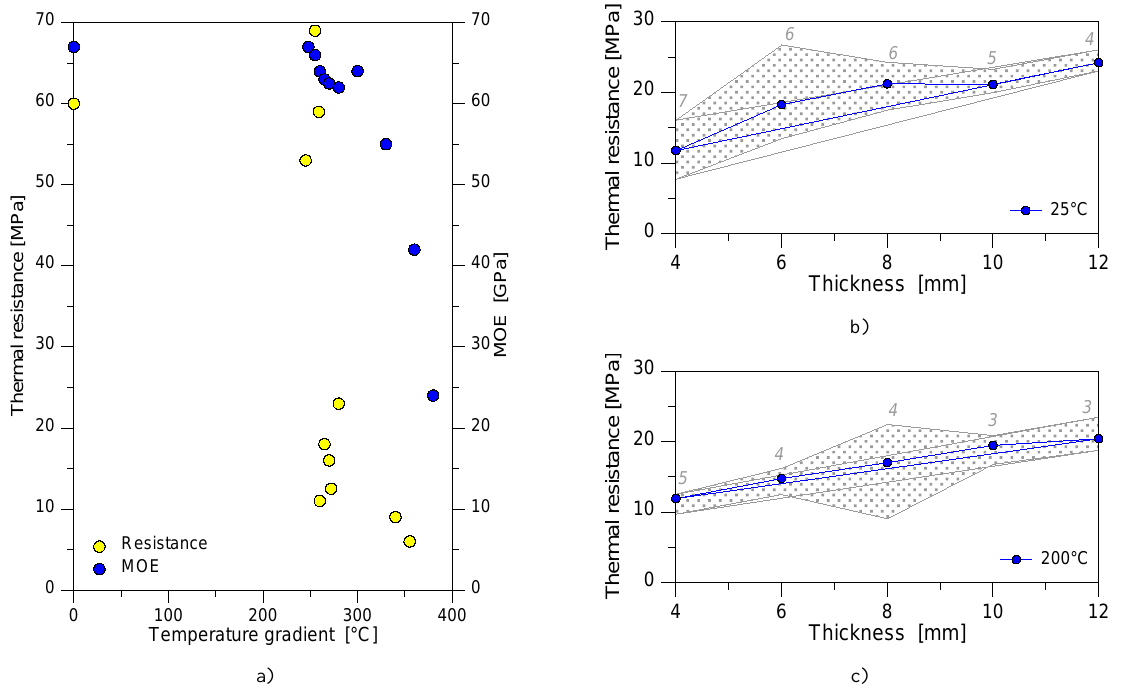
Fig. 2 Thermal characterization of SLS glass. a) Variation of MOE and resistance, under thermal shock (Malou et al., 2013) and b)-c) dependency of thermal shock resistance to glass thickness (in gray italic, the number of tests for each thickness), in accordance with (Xie et al.,